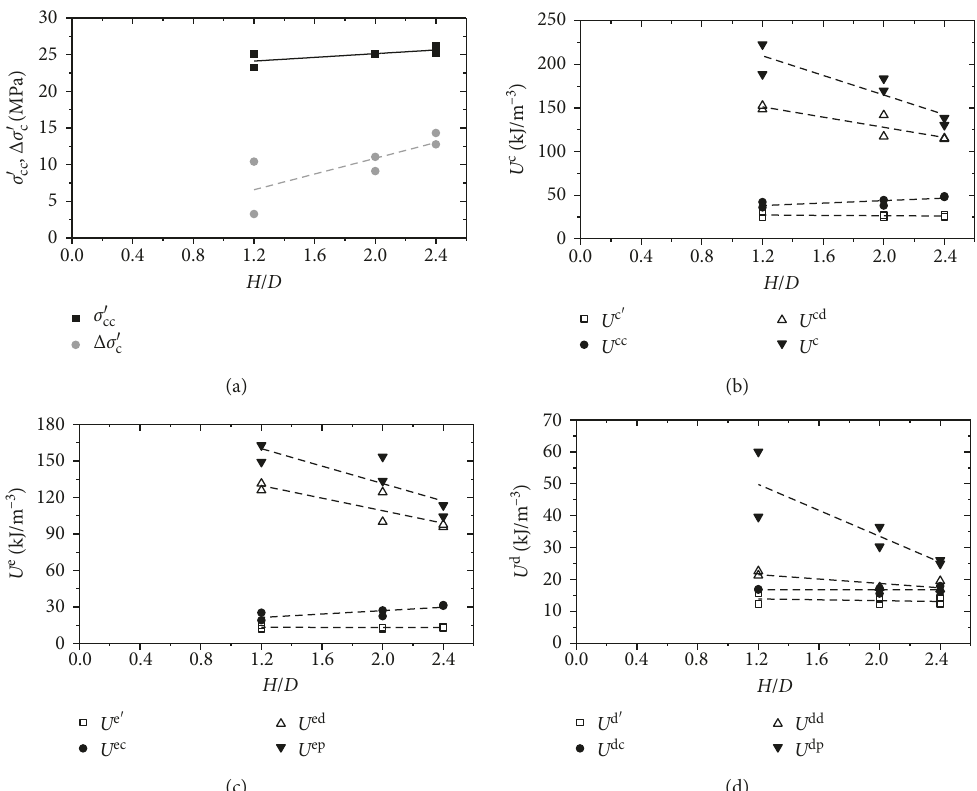
, σ c , and H/D; (b) relationship between input energy density and H / D ; (c) relationship between cc ′ ′ Δ